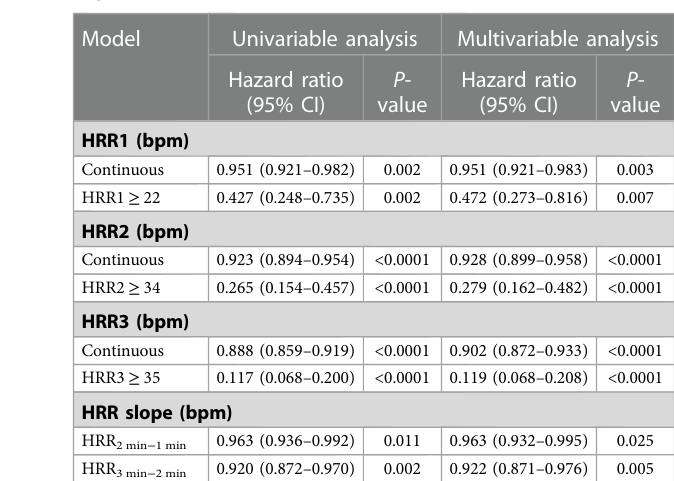
TABLE 3 Unadjusted and adjusted hazard ratios for MACE by HRR or HRR slope.